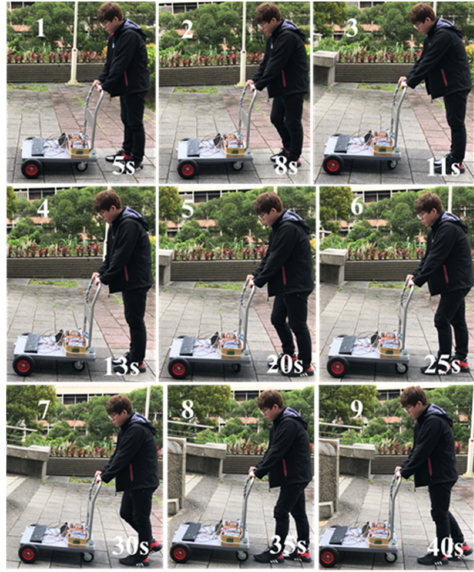
Figure 13. Snapshots of smart walker assisted in flat